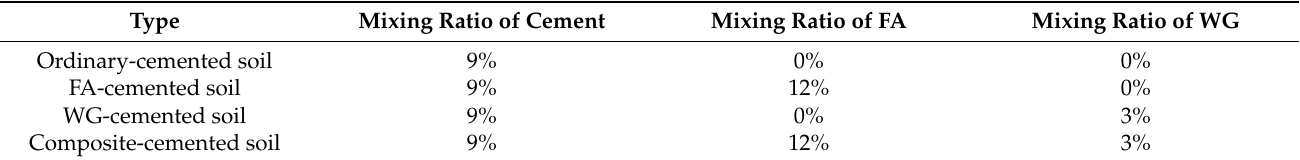
Table 7. Mix proportions of the four types of cemented